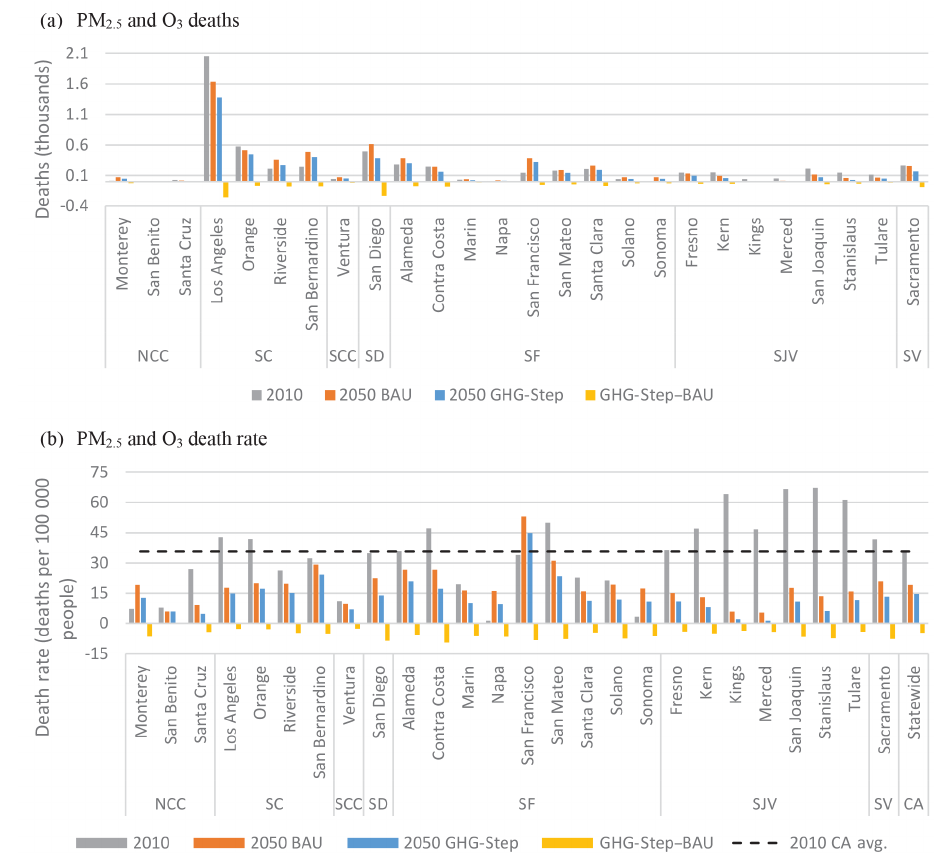
Figure 6. (a) PM 2 . 5 and O 3 long-term exposure deaths and (b) mortality rate by county, year, and emission scenario, based on combined Krewski et al. (2009) all-cause deaths associated with PM 2 . 5 risk ratio (RR) and Jerrett et al. (2009) respiratory deaths associated with ozone